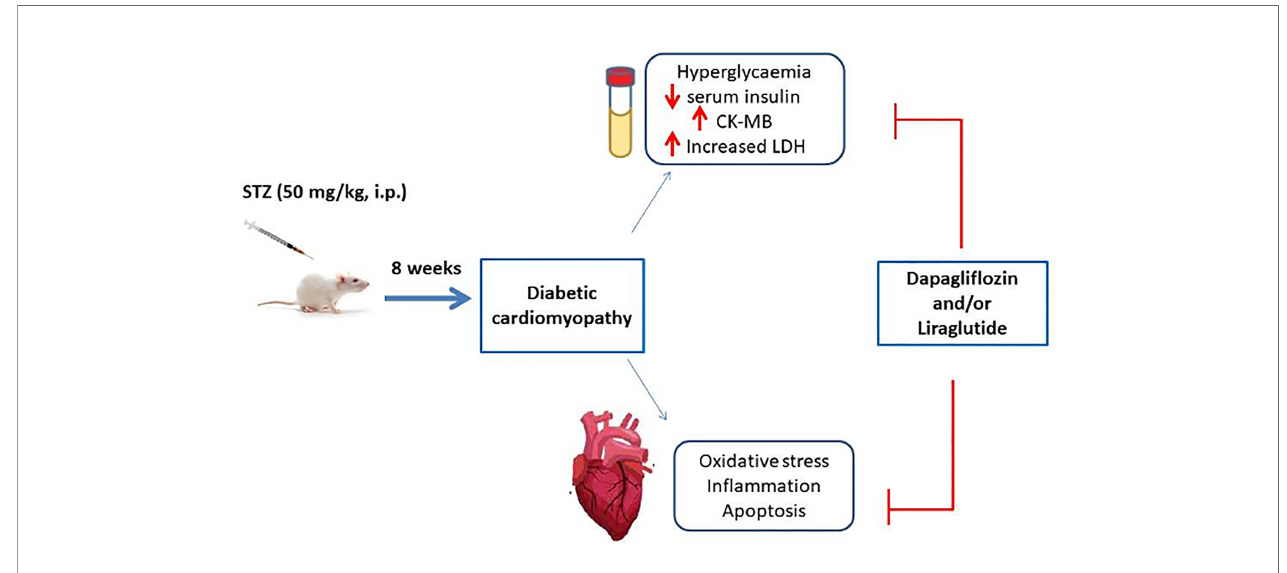
FIGURE 9 | Graphical